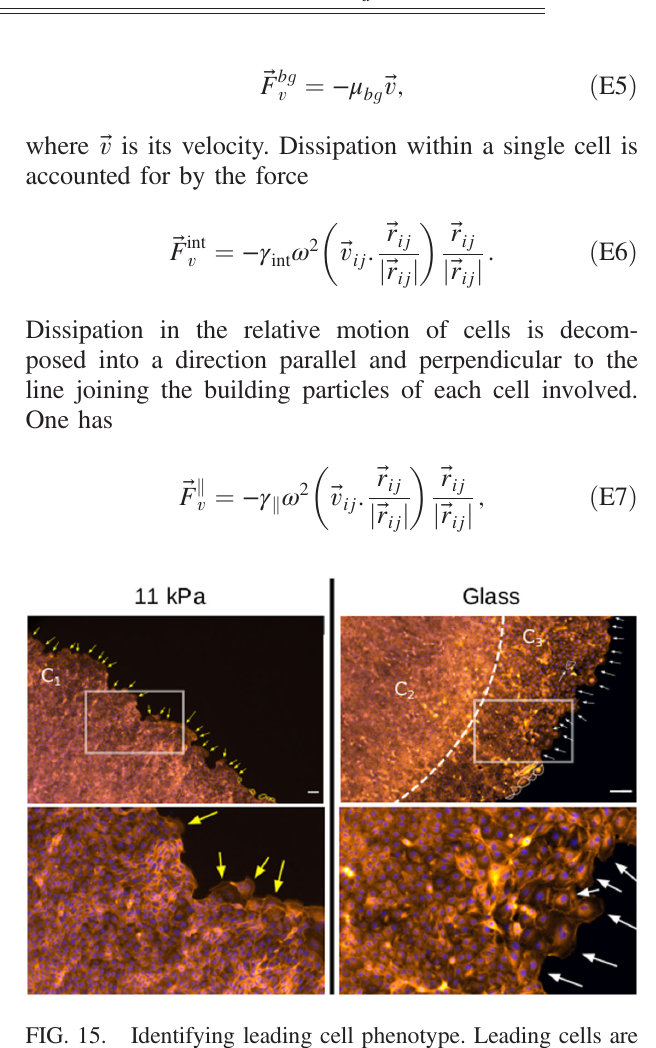
FIG. 15. Identifying leading cell phenotype. Leading cells are identified in tissues grown on hard gels (left) and glass (right). The red channel is used for actin, while the blue channel is for the nuclei. The arrows point to leader cells, and the scale bars are 100 μ m. Leader cells are, on average, larger on glass substrates [white encirclement on glass (right), yellow encirclement on gels (left)]. In contrast to gels, leader cell phenotypes [55] on glass can sometimes be seen deeper inside the tissue and not only on the borderline. The bottom row corresponds to the zoomed-in images corresponding to the highlighted rectangles in the top